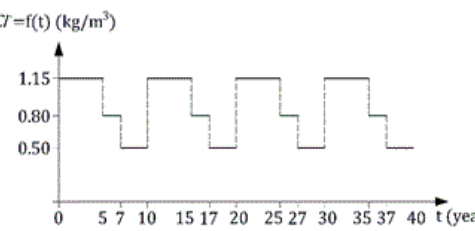
Figure 6 – Time dependent boundary conditions for case 4